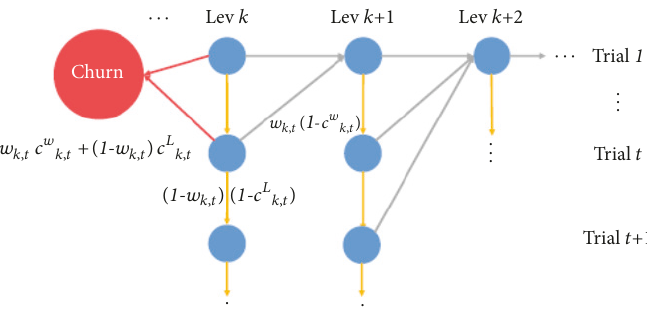
Figure 3: Probabilistic graph showing the player’s progression model in a typical level-based